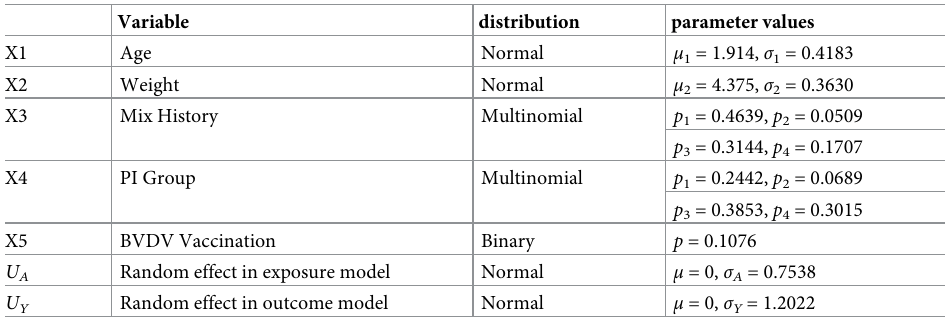
Table 7. Distribution of covariates.